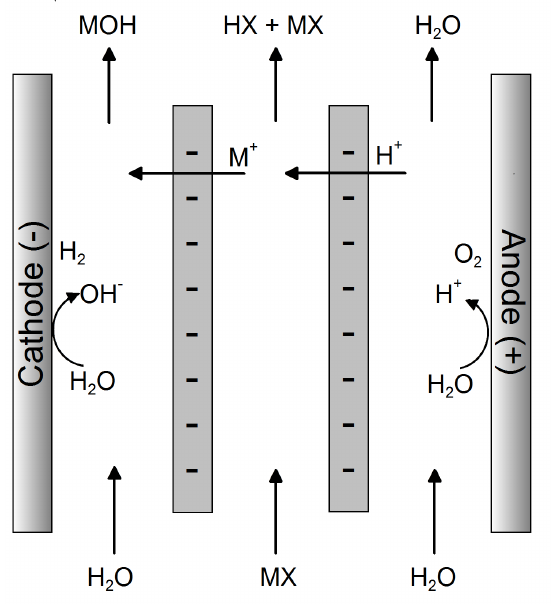
Figure 7: Schematic representation of EED combined with